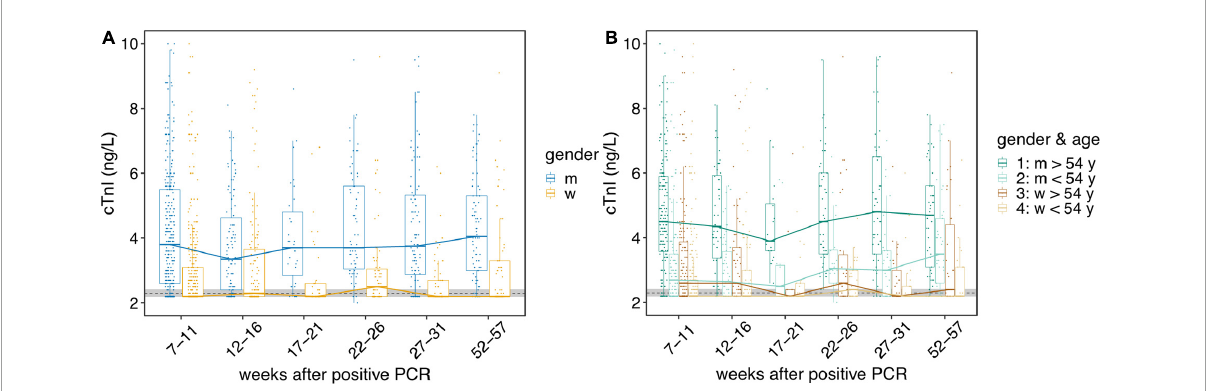
FIGURE2 The course of hs troponin I concentrations over a period of more than 1 year. The course of hs troponin I concentrations (cTnI) over a period of more than 1 year [high sensitive (Beckman Coulter Switzerland, Nyon, Switzerland) assay] after mild to moderate SARS-CoV-2 infections are displayed. Black dotted line indicate the limit of detection and limit of quantification, both at 2.3 ng/L. Horizontal bold lines indicate median values; boxes indicate quartiles 1 and 3; whiskers indicate 1.5 × IQR confidence intervals (CI). Gray shaded region indicate the 95% CI of the cTnI of the control cohort ( n = 115). Each point represents a single measurement. (A) Gender-dependent cTnI. The course of cTnI from week 7 to 57 in women (w, yellow) and men (m, blue) are displayed. (B) Course of cTnI over time split into four categories: 1: men older than 54 years (dark